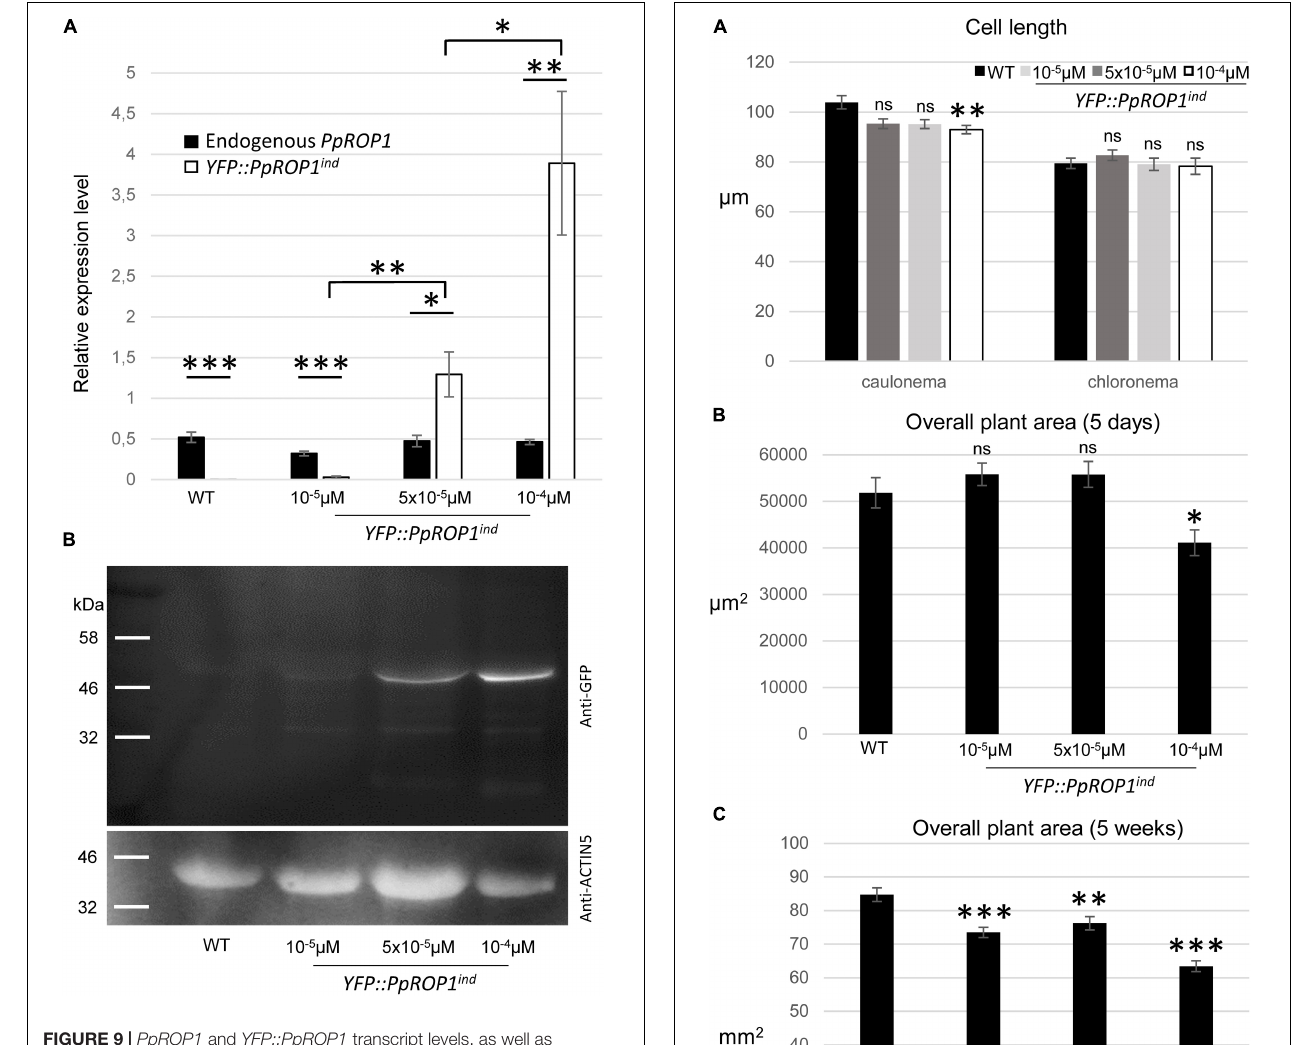
was affected only marginally and after prolonged incubation.